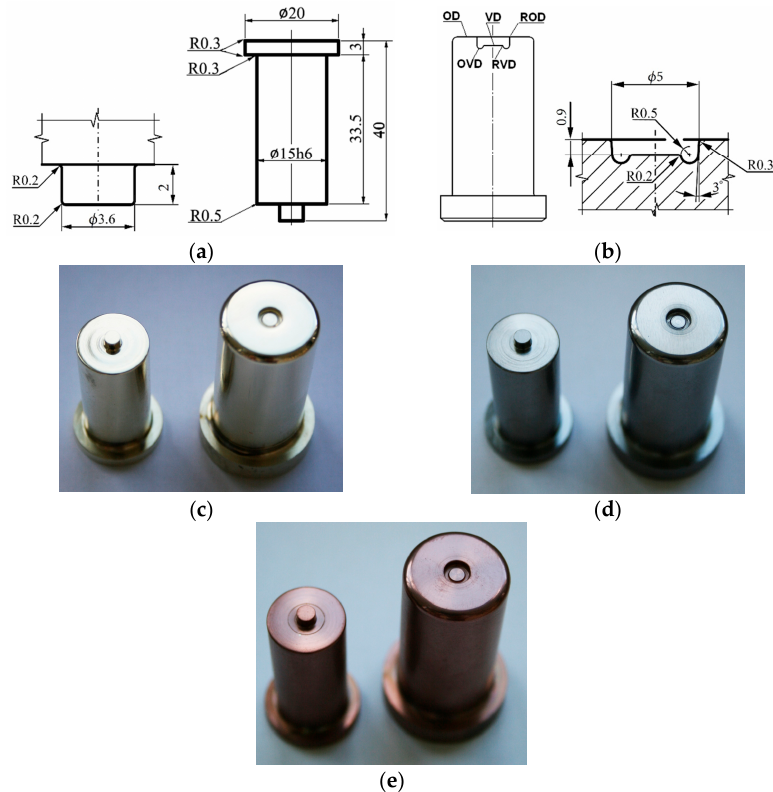
Figure 1. Clinching tool: ( a ) punch; ( b ) die; tool covered with ( c ) ZrN coating; ( d ) CrN coating and ( e ) TiCN MP coating. (unit: mm).